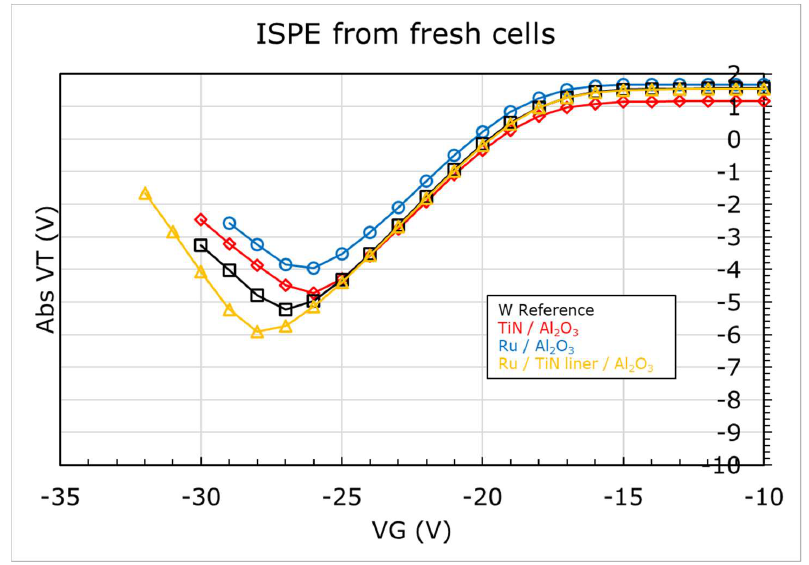
Figure 11. Incremental Step Pulse Erase (ISPE) of (Metal/High-k/ONO/Si) MHONOS, for different metal/high-k combinations from Figure 10.